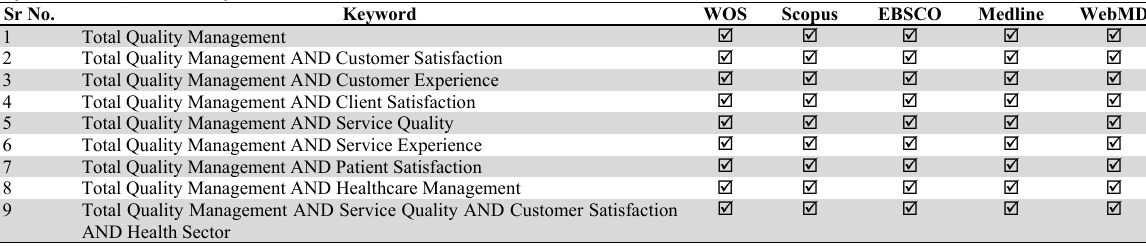
Table 1 Keywords for Qualitative Systematic Review Sr